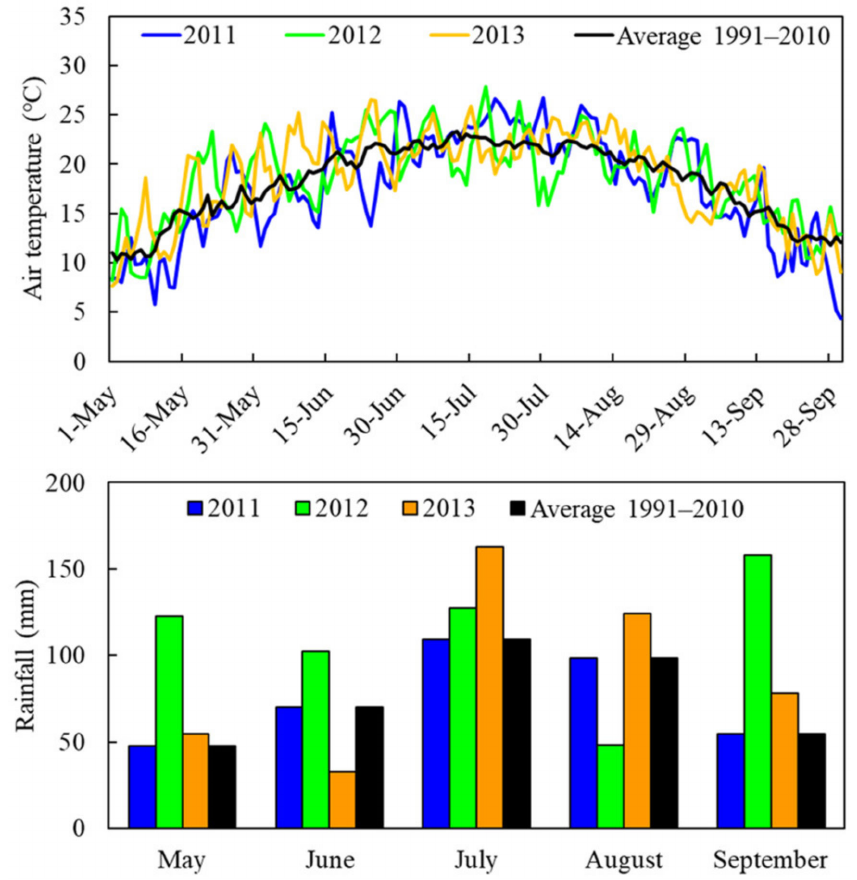
Figure 1. The average daily temperature and monthly rainfall in the 2011–2013 experimental period compared to the 20-year (1991–2010) normal in Jiansanjiang, Heilongjiang Province,